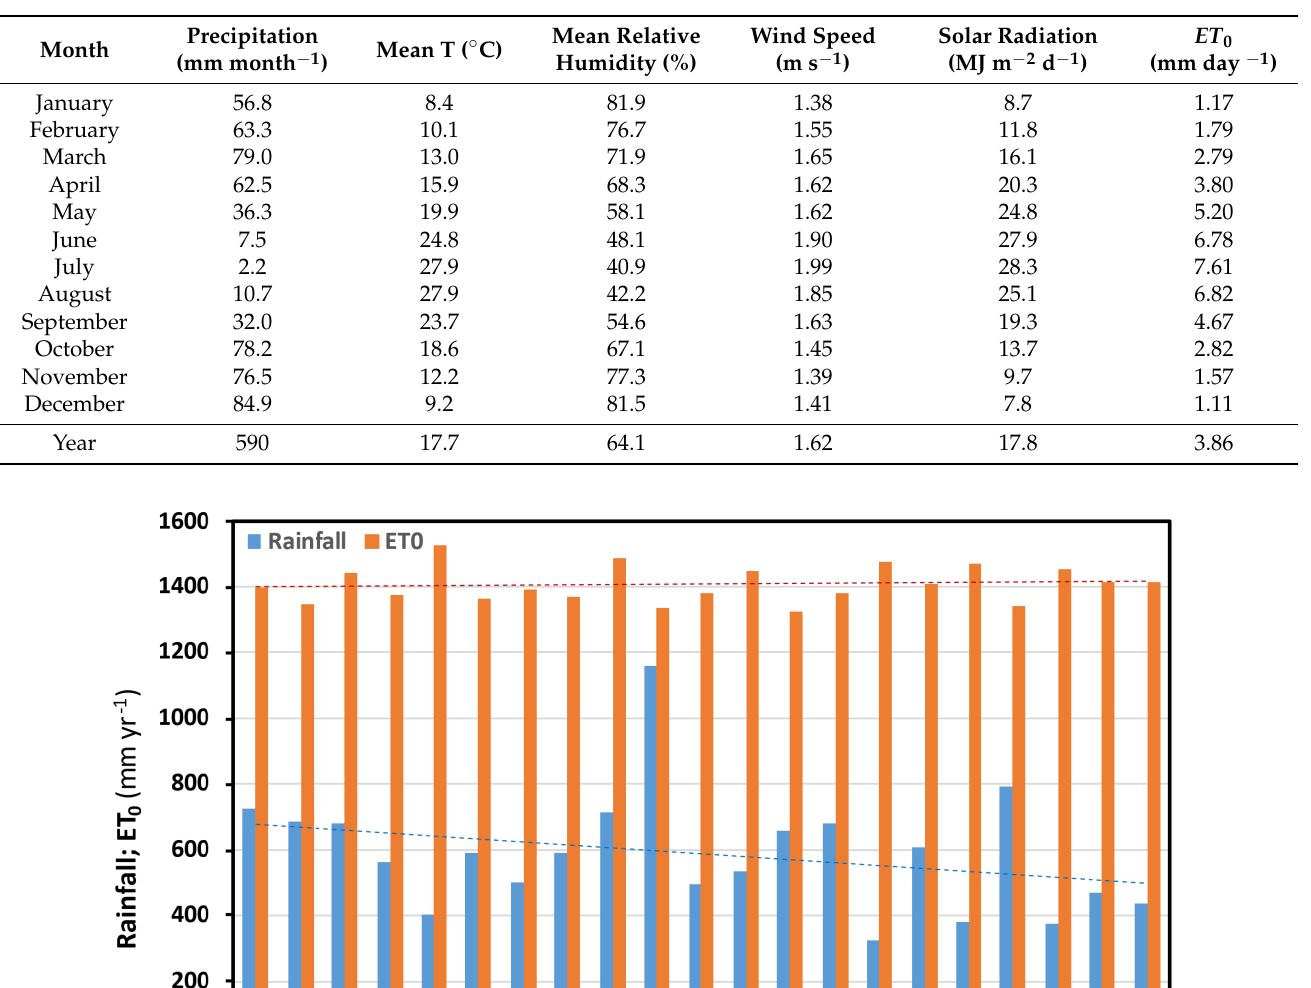
Table 1. Average climatic data in C ó rdoba (Andalusia; southern Spain) during the period from 2001 to 2021, obtained from the C ó rdoba agroclimatic station belonging to the Andalusian Agroclimatic Information Network (RIA).